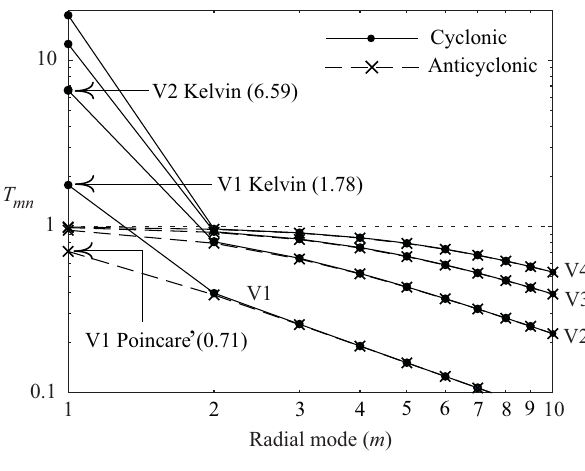
Fig. 2. Modal velocity amplitudes for B = 2, h 2 = 1 and h 3 = 2. All values are normalized by the value of the Kelvin wave of vertical mode-one A (v) . Amplitudes of geostrophic waves are plotted on 11 radial mode-one as reference